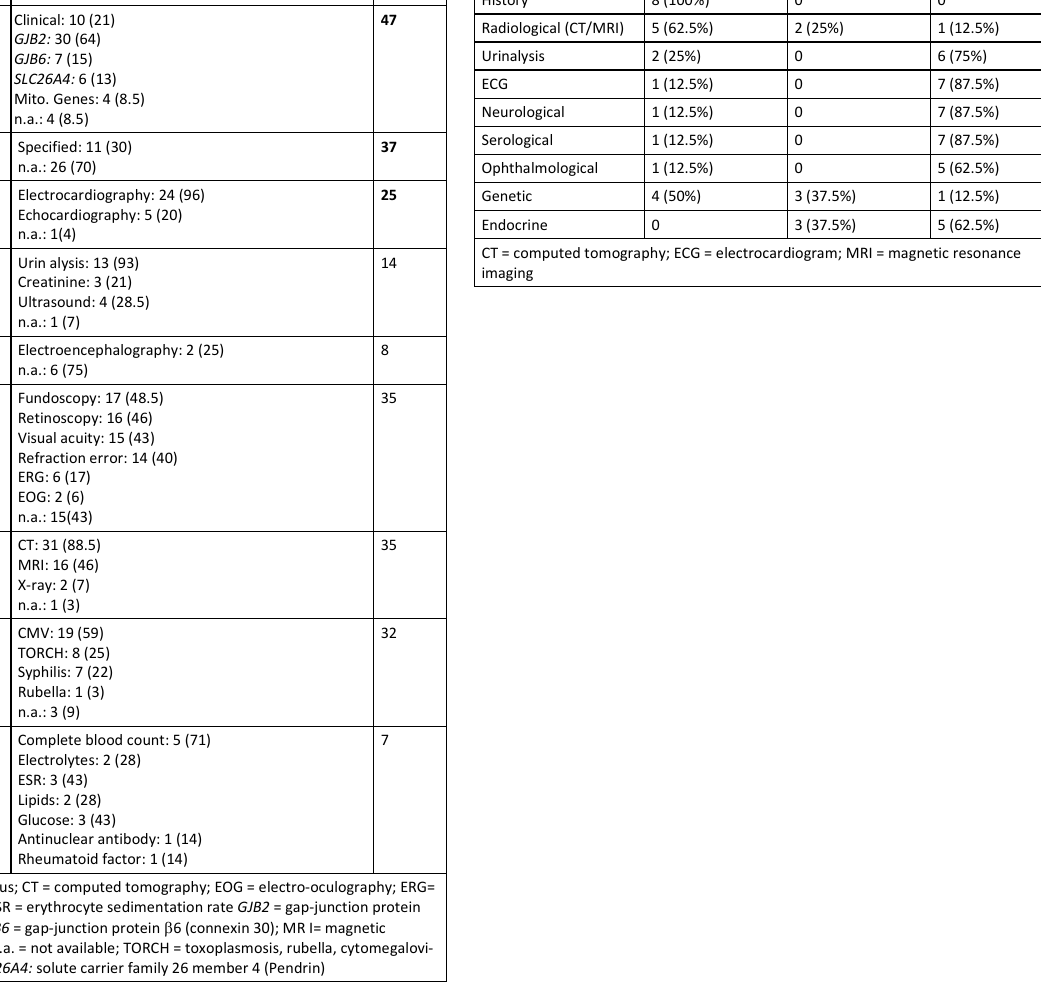
Table 3: Number (percent) of studies including various aetiological investigations and type of examination. Endocrine Thyroid function test:12 (100) Perchlorate test:1 (8.5) Genetic